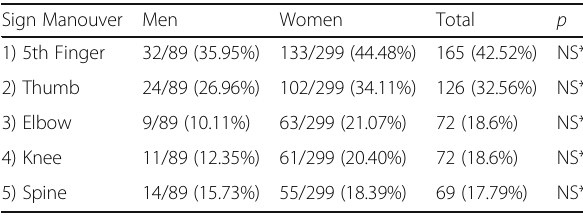
Table 3 Comparison of the frequencies of joint hypermobility signs scored in the Beighton Scale according to